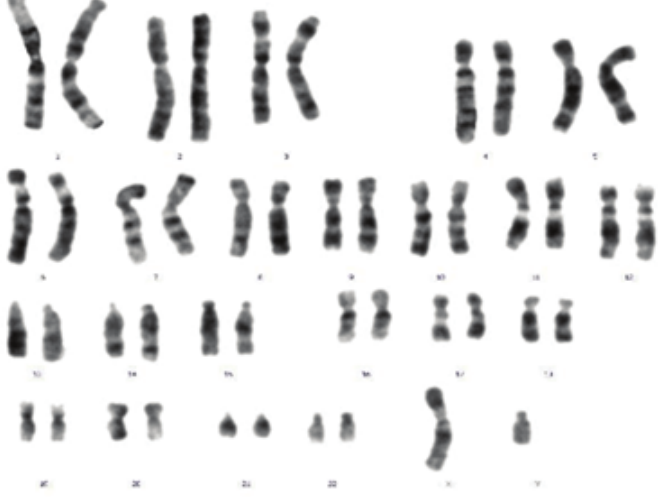
Figure 1: Normal male karyotype 46,XY.